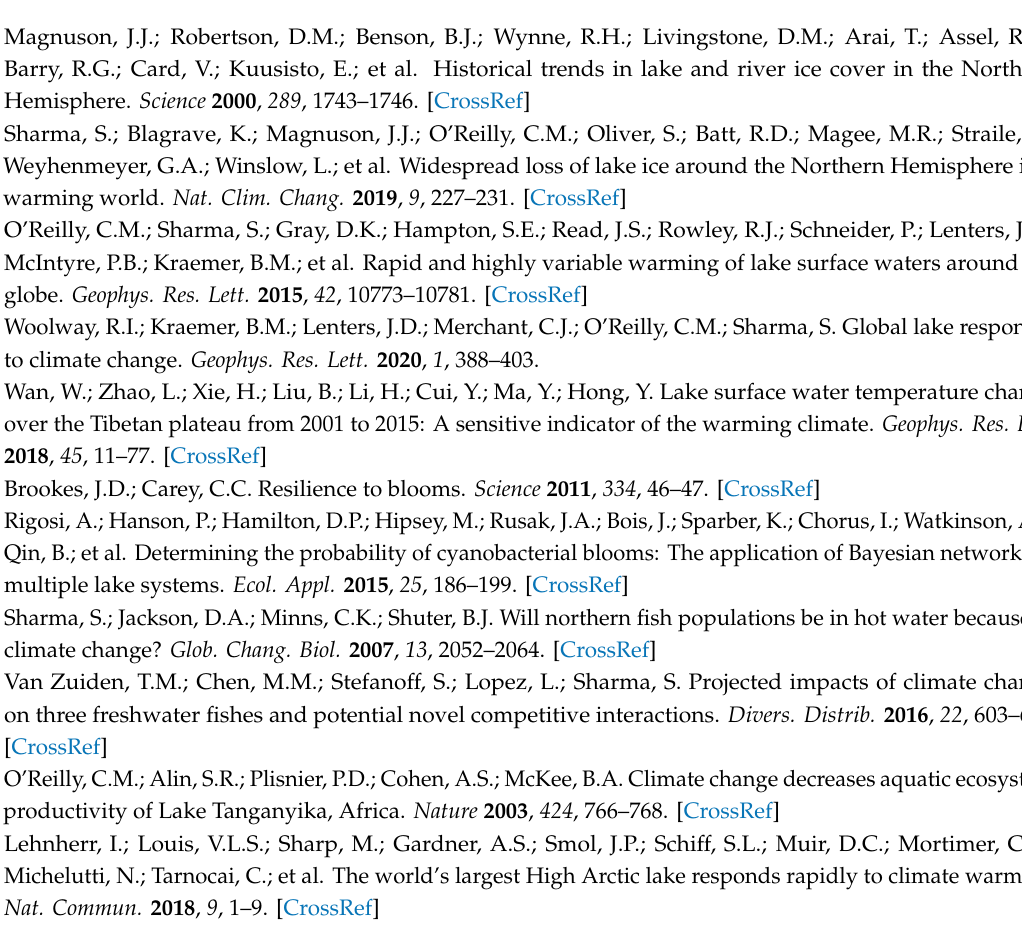
Table S1: Calculated heating rates by month for each of the 1033 lakes in our statistical sample. Table S2: Average monthly heating rates by